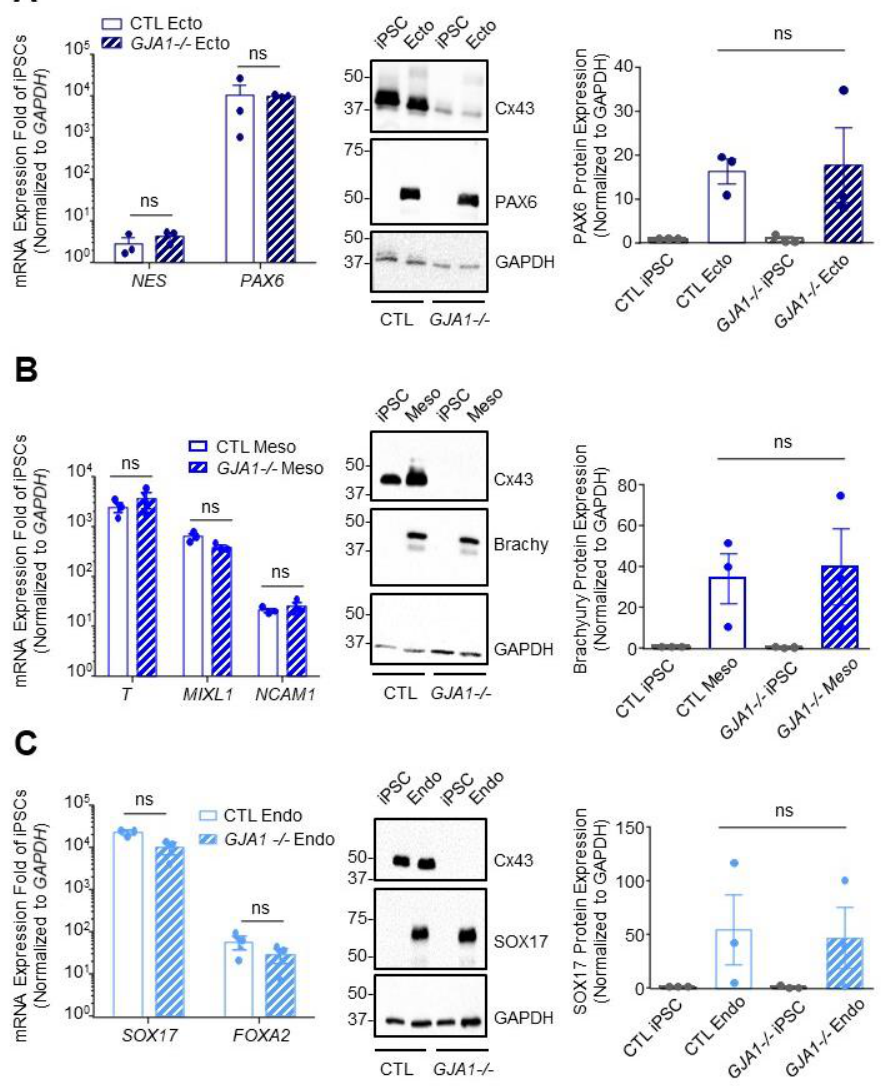
Figure 5. Cx43 knockout iPSCs successfully differentiate to cells of each germ lineage under directed differentiation conditions. Quantitative RT-PCR (qPCR) screen, representative Western blots, and densitometry of differentiated control and Cx43 knockout ( GJA1-/- ) iPSCs. ( A ) Ectoderm formation indicated by presence of NES and PAX6 transcripts and expression of PAX6 protein. ( B ) Mesoderm evaluated by identifying transcripts for T, MILX1 , and NCAM1 , and expression of Brachyury protein. ( C ) Endoderm formation confirmed by FOXA2 and SOX17 transcripts and expression of SOX17 protein. Data represent the standard error of the mean of 3 – 4 independent experiments. ns: not significant compared to control cells.